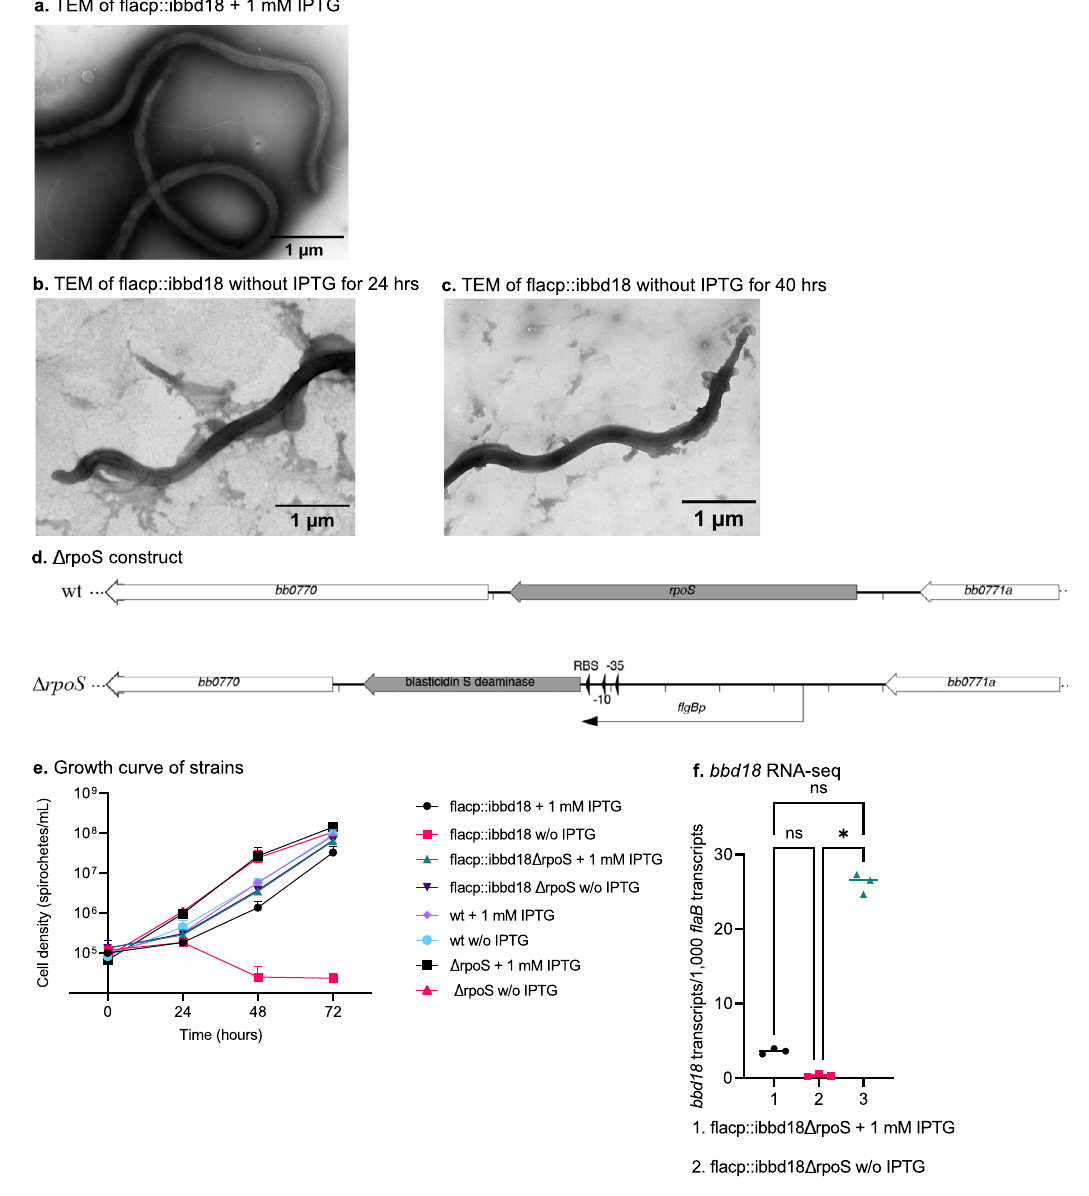
Fig. 4 | Unmodulated expression of rpoS following de-induction of bbd18 is responsible for B. burgdorferi lysis in vitro. ( a-c ) Representative TEM images of fl acp::ibbd18 cells cultured with or without IPTG. a fl acp::ibbd18 cells are intact in the presence of IPTG/BBD18. Flacp::ibbd18 cells bleb and lyse ( b and c ) after the removal of IPTG from the culture medium. TEM was performed on spirochetes from two biological replicates with representative images shown. d Genetic orga- nization of the rpoS locus in wt and Δ rpoS strains. e Growth curve of B. burgdorferi fl acp::ibbd18, fl acp::ibbd18 Δ rpoS,wt,and Δ rpoSstrainsintheabsenceorpresence